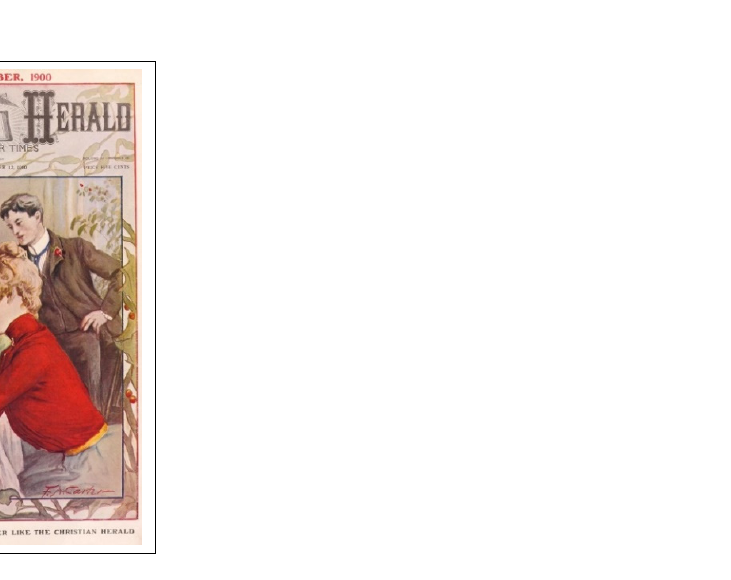
Figure 1. Self Portrait. Christian Herald , 12 December 1900. All images are in the public domain, accessed from The Internet Archive, digital sponsor, Tisch Library, Tufts University, contributing library, the Christian Herald Association.